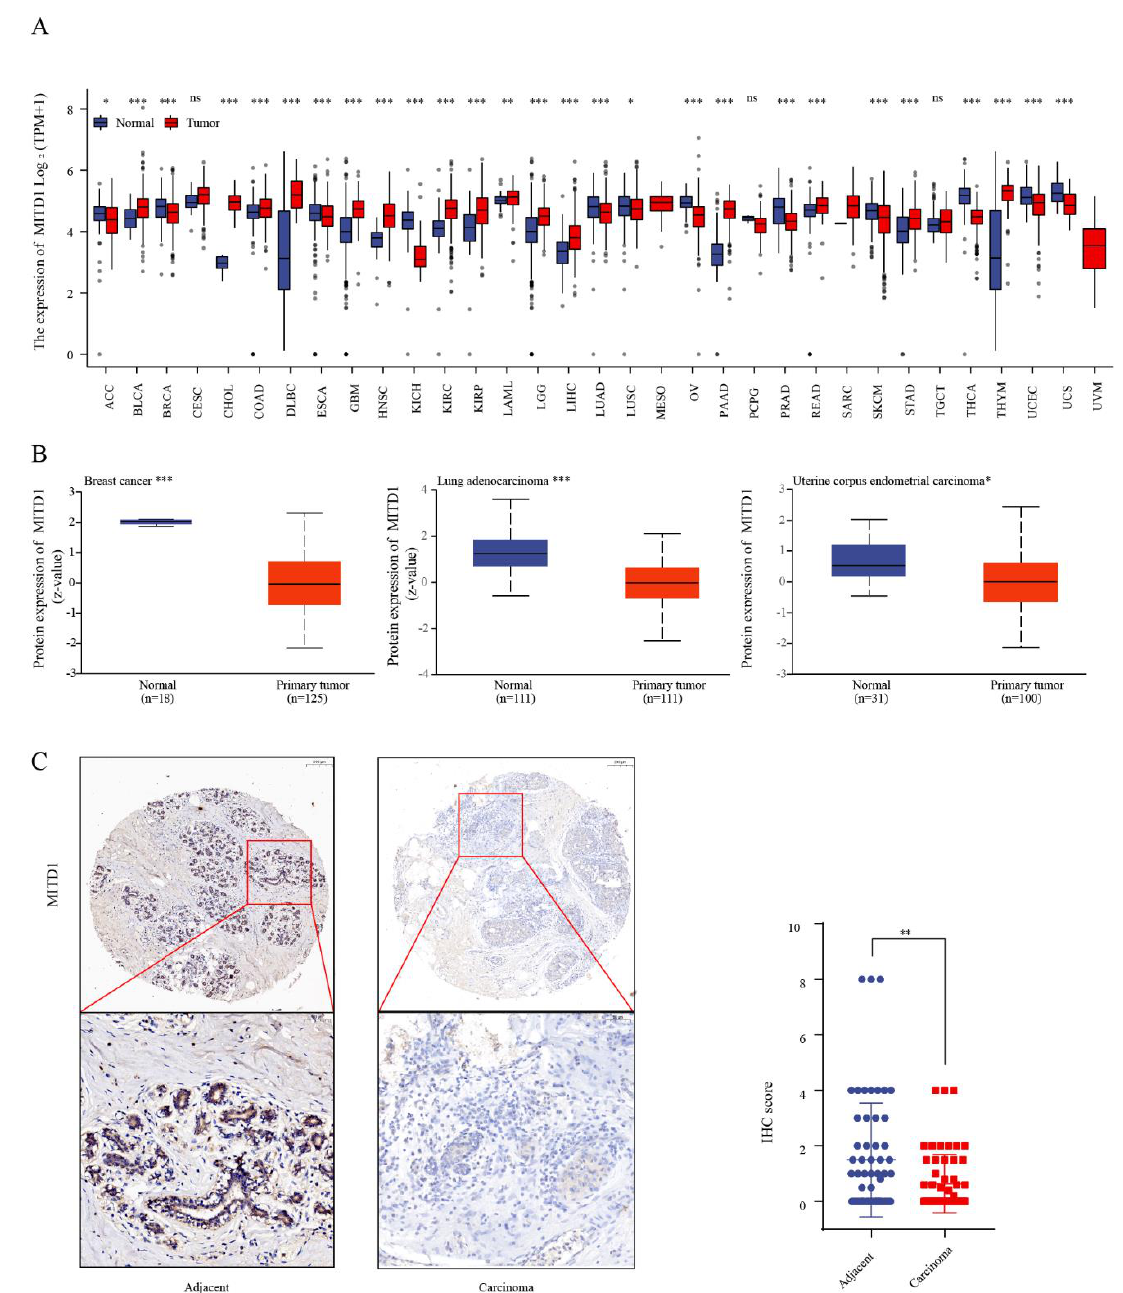
Figure 2. Expression level of MITD1 in different cancers. ( A ) MITD1 expression levels in different cancers and corresponding normal tissues. ( B ) MITD1 total protein expression in different cancers. ( C ) Representative immunohistochemistry (IHC) staining images of breast cancer tissue microarray and analysis of IHC scores. * p < 0.05; ** p < 0.01; *** p <